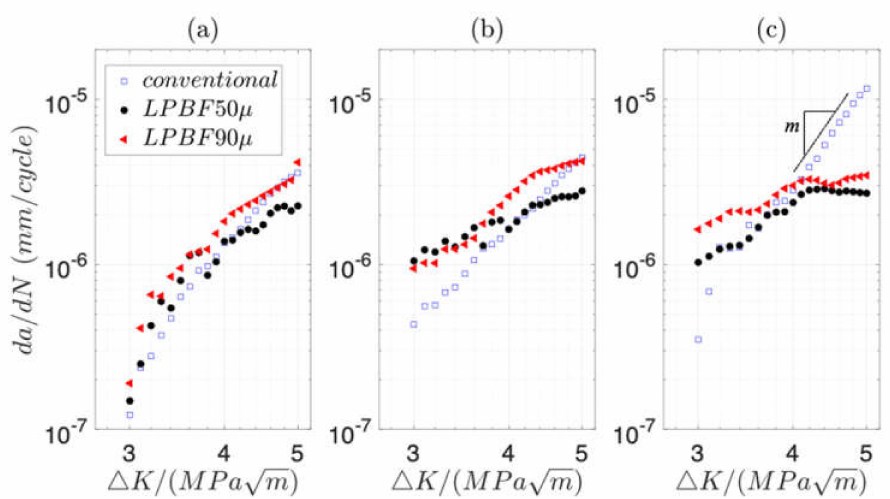
Figure 6. Fatigue crack growth kinetics of 316L SS at different corrosion fatigue parameters for conventional (labeled as conventional) and two LPBF samples at H = 90 µ m and H = 50 µ m (la-beled as LPBF90 µ and LPBF50 µ , respectively) at R = 0.833 in ( a ) air, ( b ) 3.5 wt.% NaCl solution at 20 Hz and ( c ) 3.5 wt.% NaCl solution at 2